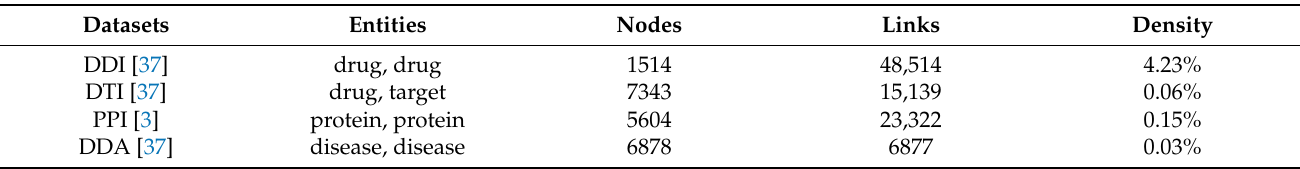
Table 1. Summary of datasets used in our experiments.